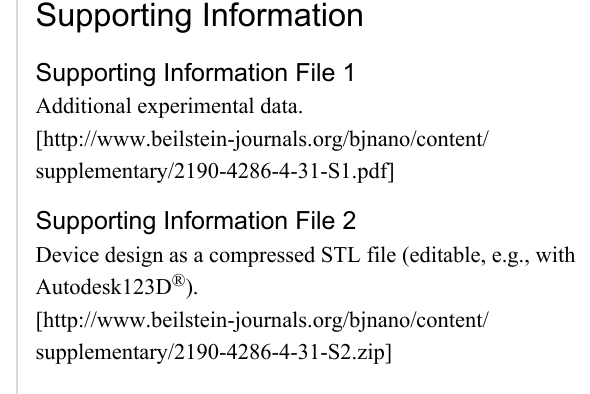
Figure 4: Normalised intensity plotted against time showing the change in intensity of [Ni(C 24 H 24 N 6 )(NO 3 )] + ( 2 ), m / z 516.1, (black) and [Cu(C 24 H 24 N 6 )(NO 3 )] + ( 1 ), m / z 521.1, (red) over five pump cycles. (The dotted lines correspond to the instability in the intensity of the species due to the pumps refilling, and thus, the system is not at equilibrium).